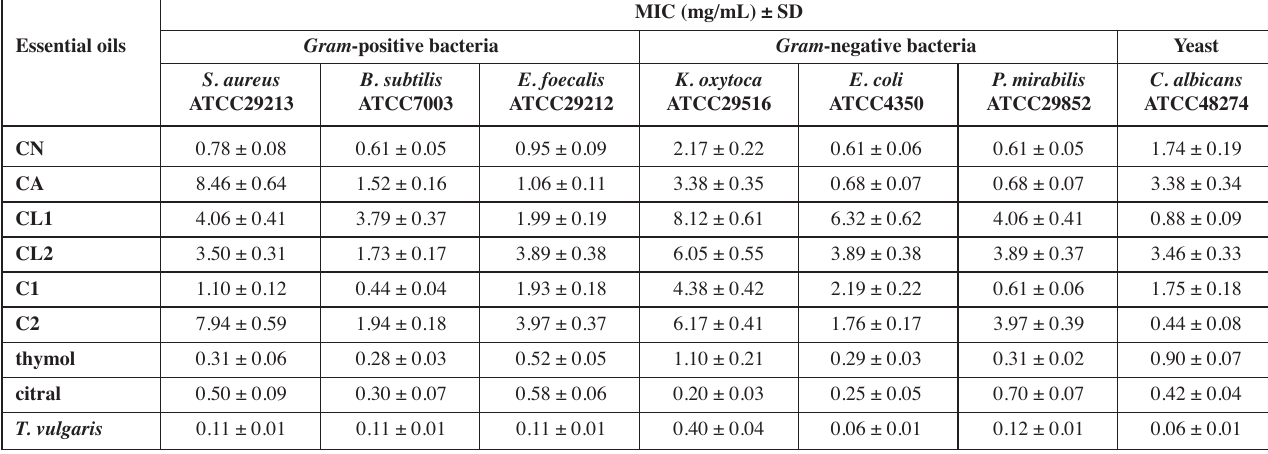
Tab. 3: Antimicrobial activity of Citrus petitgrains compared to commercial Thymus vulgaris essential oil, thymol and citral.